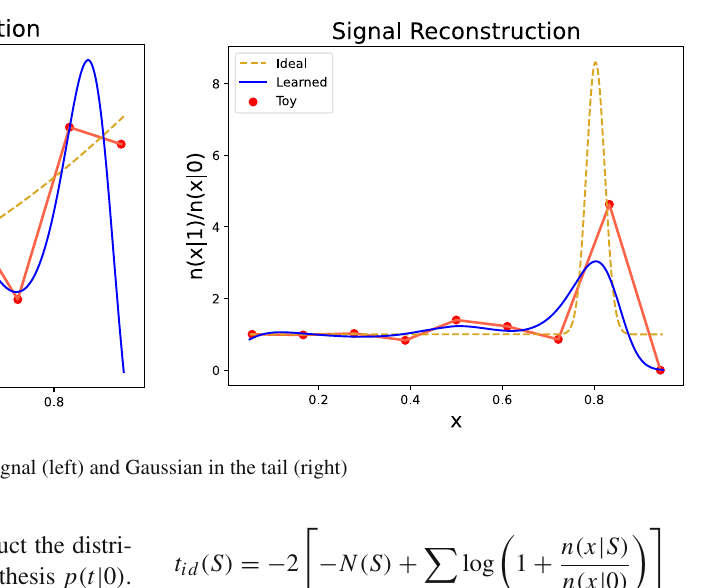
Fig. 12 a Distribution of the test statistics under the null and alternative hypotheses (non-resonant signal). b Empirical and χ 2 null distributions, integrated to p-values